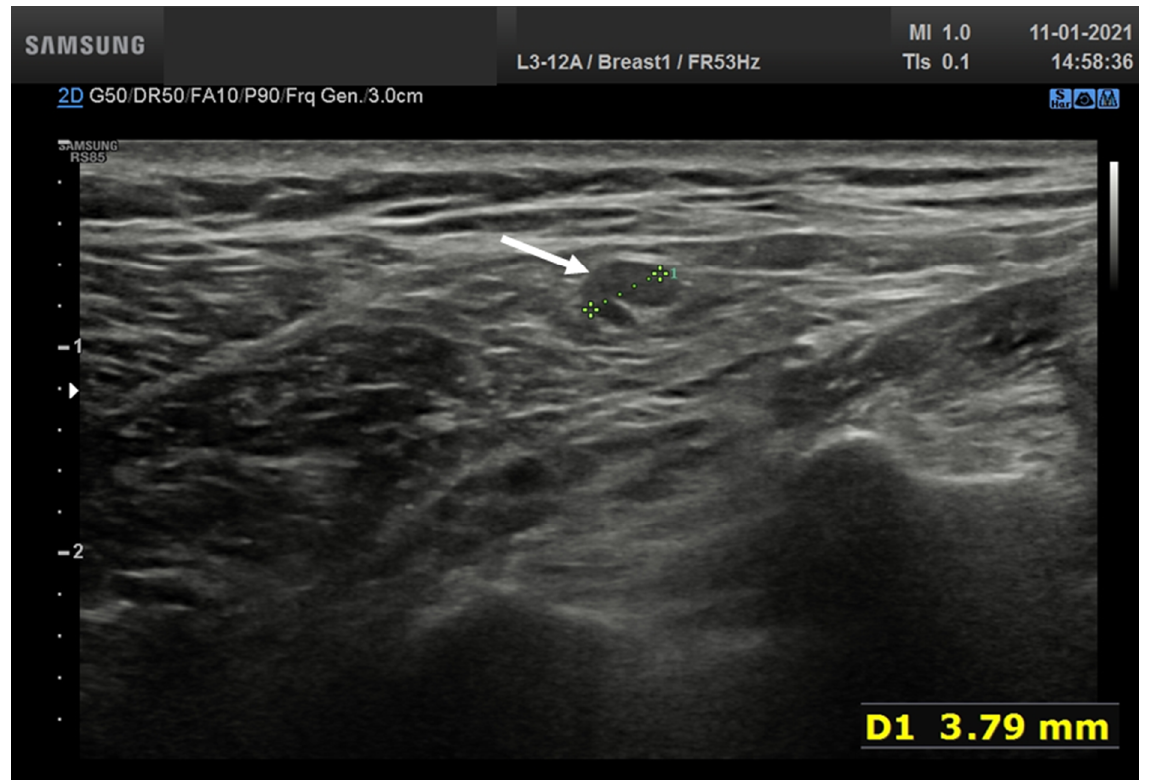
Figure 3. Lymph node (arrow) with asymmetric eccentric concentric cortical thickening in laterocervical side with reduction in the width of the echogenic hilum and oval shape.